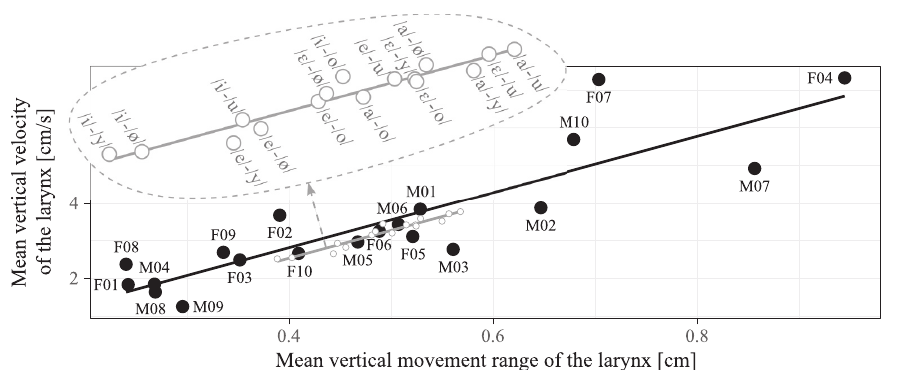
Fig 5. Linear relationships between the mean vertical movement range of the larynx and the mean vertical velocity of the larynx across the subjects and across the vowel pairs. Each black point represents the value pair for one specific subject, for which the values were pooled across both the vowel pairs and the speaking rates, and each gray point represents the value pair for one specific vowel pair, for which the values were pooled across both the subjects and the speaking rates. The linear relationships that were found for the subjects ( ρ = 0.812, p < 0.001) and for the vowel pairs ( ρ = 0.936, p < 0.001) are displayed in terms of the regression lines. The intercept and the slope of the regression lines were -0.15 cm/s and 7.40 Hz, respectively, for subjects, and -0.43 cm/s and 7.38 Hz, respectively, for vowel